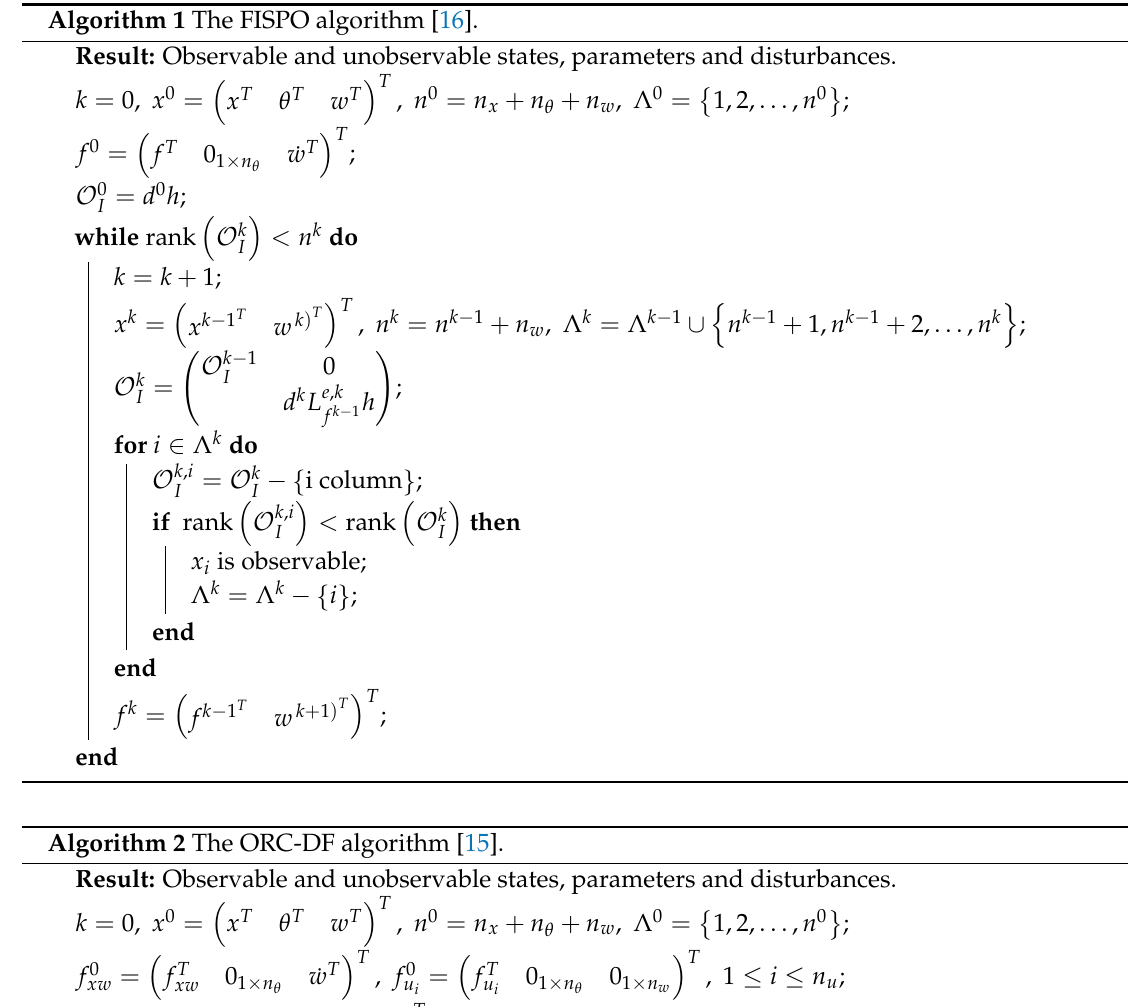
Algorithm 1 The FISPO algorithm [16].